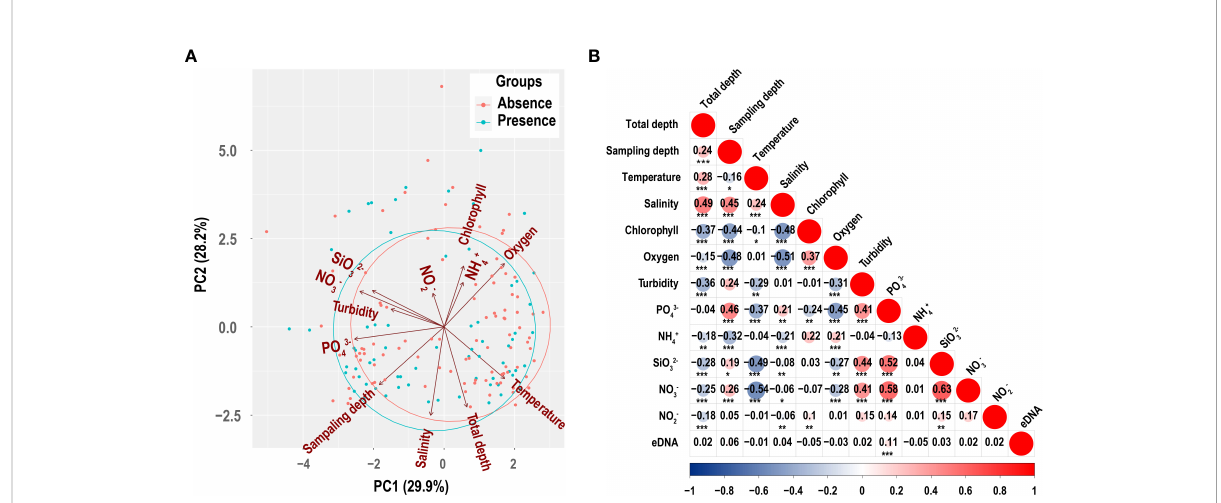
FIGURE 5 Principal component analysis (PCA) of environmental factors (A) and the correlation between environmental factors with the concentration of P. echinogaster eDNA (B) . Numbers indicate correlation coef fi cients between variables. Circle size is proportional to correlation. In addition, red circles represent positive correlation and blue represent negative correlation. The signi fi cance level is marked with * (0.05< p ≤ 0.1), ** (0.01< p ≤ 0.05), and *** ( p ≤